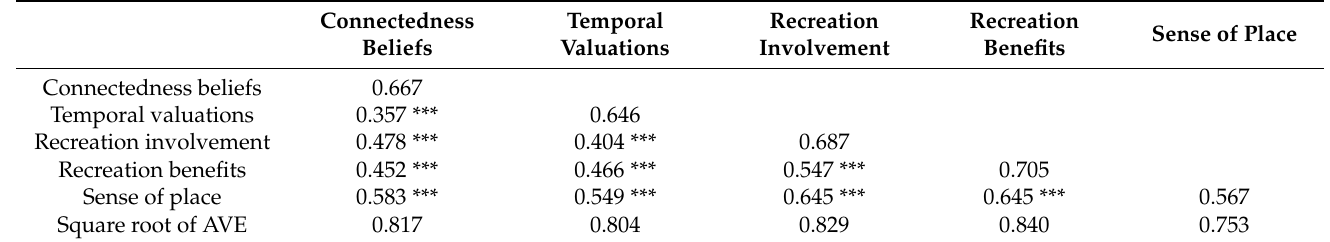
Table 4. Discriminant validity analysis of the